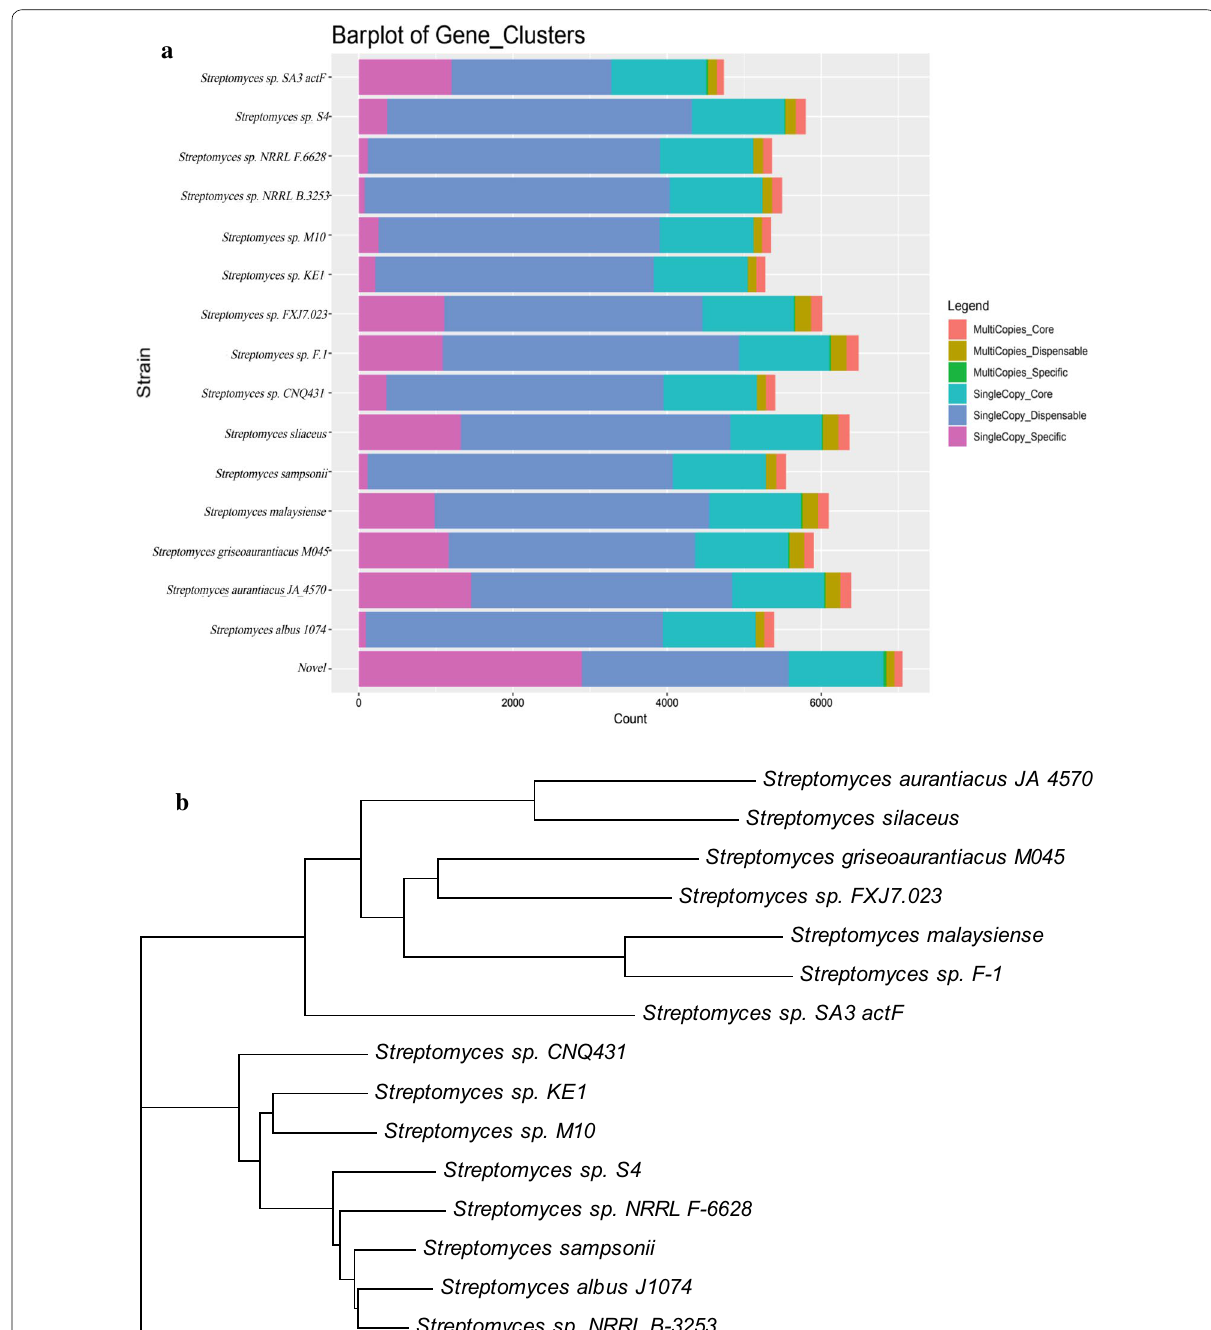
Fig. 2 a Histogram of the number of homologous genes. b Phylogenetic tree based on pangenes constructed by neighbor-joining